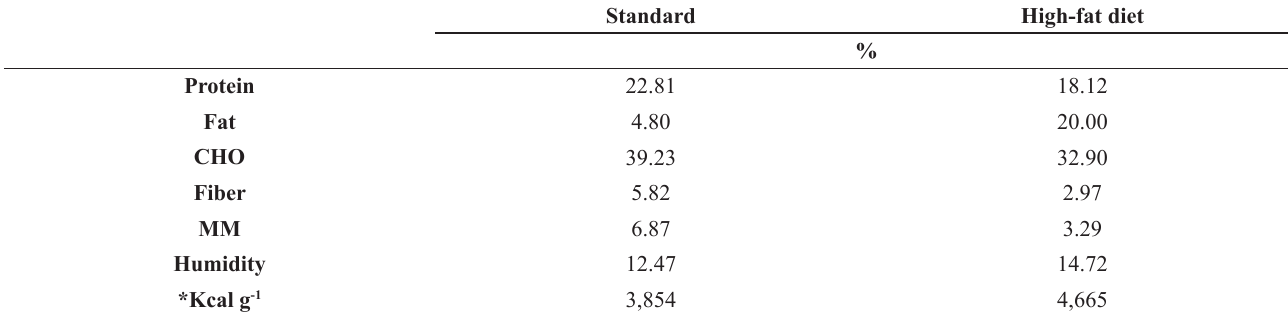
Table 1 - Composition of the standard- and high-fat